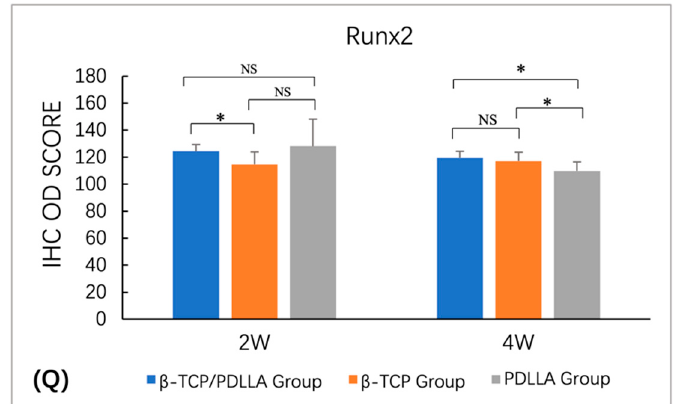
Figure 6. Immunohistochemical staining of Runx2 in the β -TCP/PDLLA ( n = 3), β -TCP ( n = 3), PDLLA ( n = 3), and sham ( n = 3) groups. ( A – H , E’ – H’ ) Sections at 2 weeks after mandibular defect surgery. ( I – P , M’ – P’ ) Sections at 4 weeks after mandibular defect surgery. UM, upper mandible; LM, lower mandible; RM, residual material; NB, newly formed bone; CN, connective tissue; OD, optical density. All slices are shown at ×4, ×10 and ×40 magnification. Scale bars: 500 μ m (black), 200 μ m (red), and 50 μ m (blue). ( Q ) OD of Runx2 was analyzed using the Kruskal–Wallis test and the pairwise comparisons were used as the post hoc test; * p < 0.05; NS, not significant. Error bars indicate standard deviation.